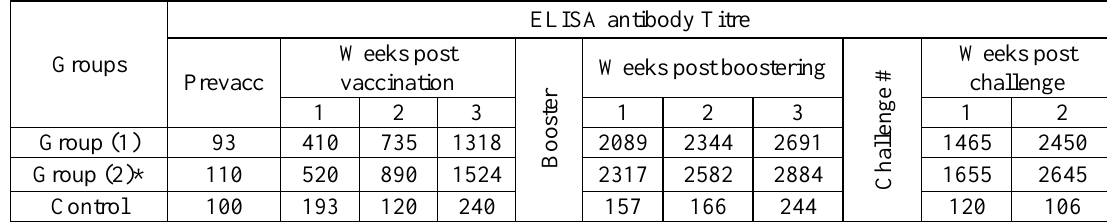
Table 4: ELISA titer in sera of vaccinated turkey poults using O78 antigen and challenged with E.coli serotype O78: